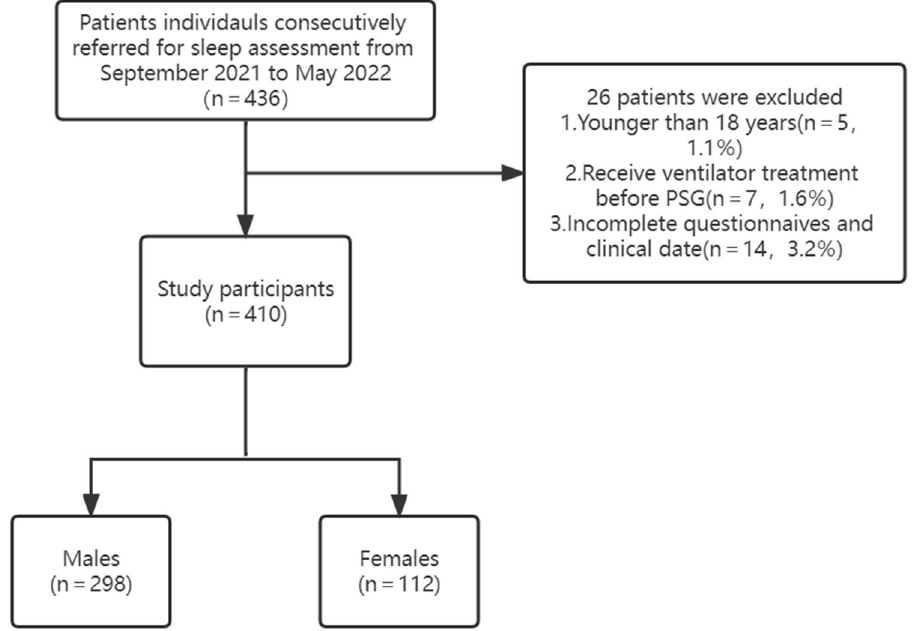
Figure 1. Flow chart showing the subject enrollment. PSG